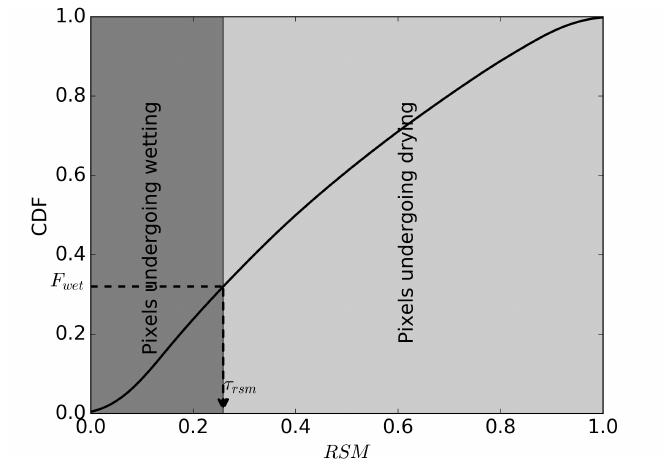
Figure 5. Computation process of the threshold of the relative soil moisture ( τ rsm ) to identify pixels undergoing wetting based on the CDF of relative soil moisture and F wet .